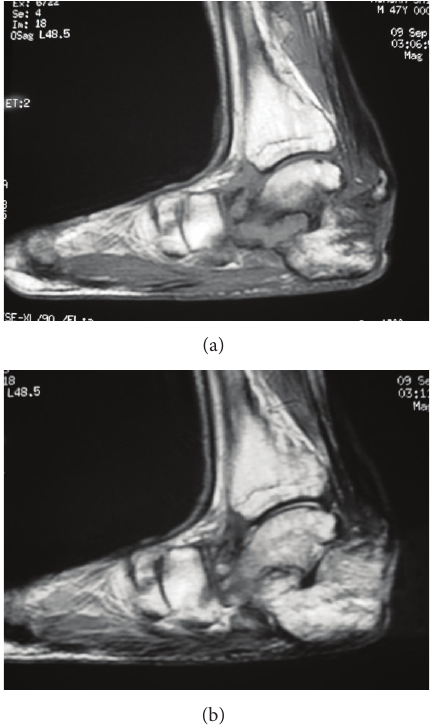
Figure 6: Magnetic resonance imaging of one year after operation. (a) T1-weighted sagittal imaging shows diffuse high signal intensity in posterior calcaneus. (b) T2-weighted sagittal imaging shows diffuse high signal intensity in the same region.